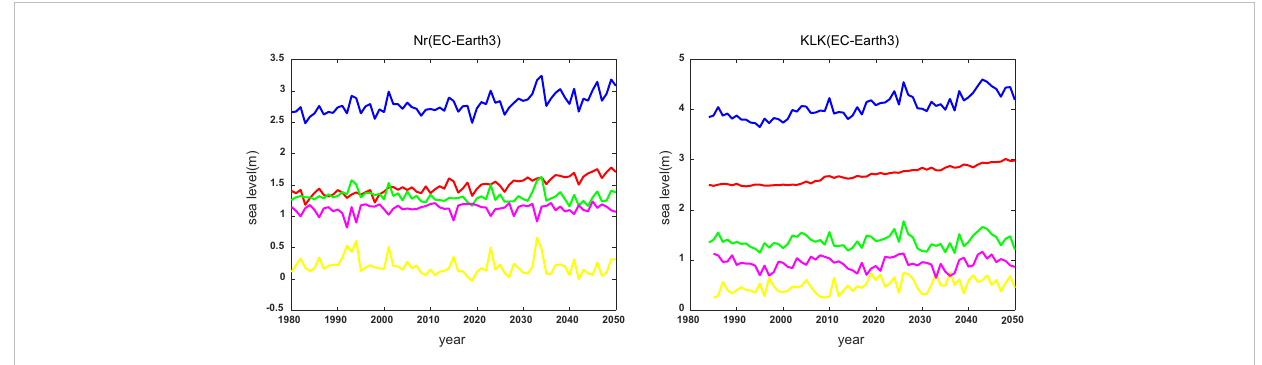
FIGURE 6 Comparison of ESL components at Nr and KLK stations: ESL (blue line), mean sea level (red line), sea level caused by tide plus extreme weather (green line), by tide (pink line) only, and by extreme weather (yellow line)